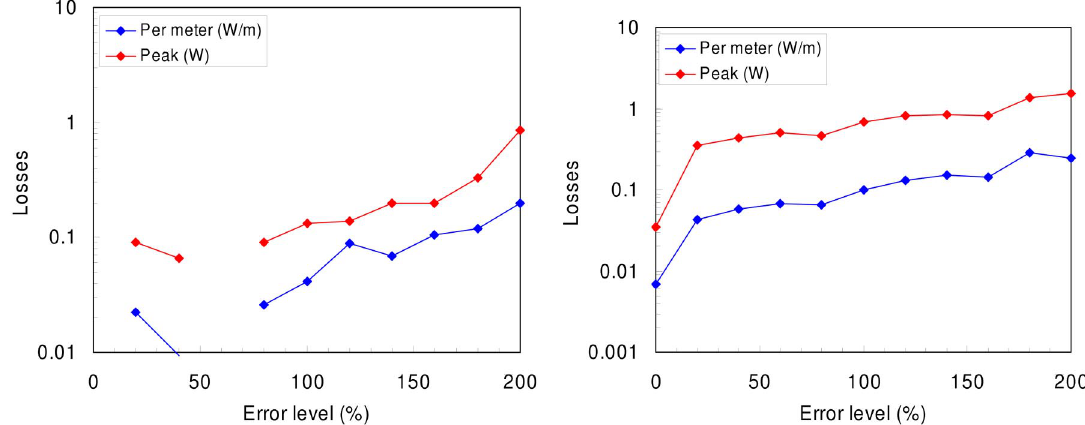
).FIG. FIG. 12. (Color) The deuteron losses in the SCL warm part in respect to the error level (first and second family of (cid:3) FIG. 14. (Color) The deuteron losses and rms emittance growths FIG. 13. (Color) The deuteron losses in the HEBT line in respect in the whole linac in respect to the error level (the whole linac to the error level. without error is the